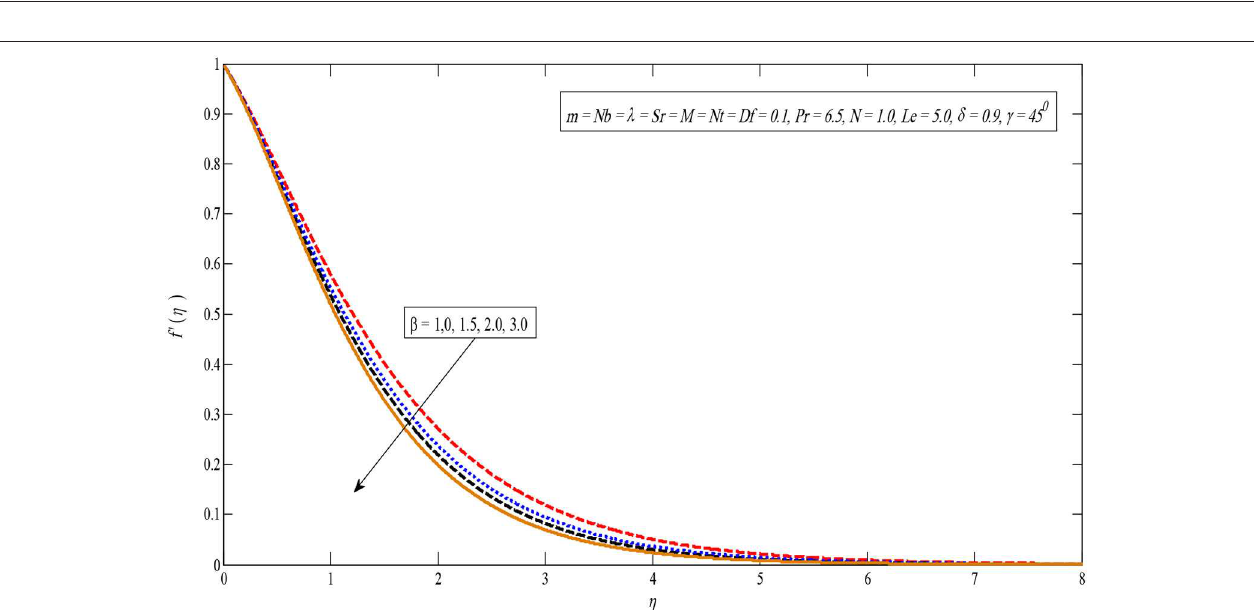
FIGURE 7 | Velocity profile for several values of β